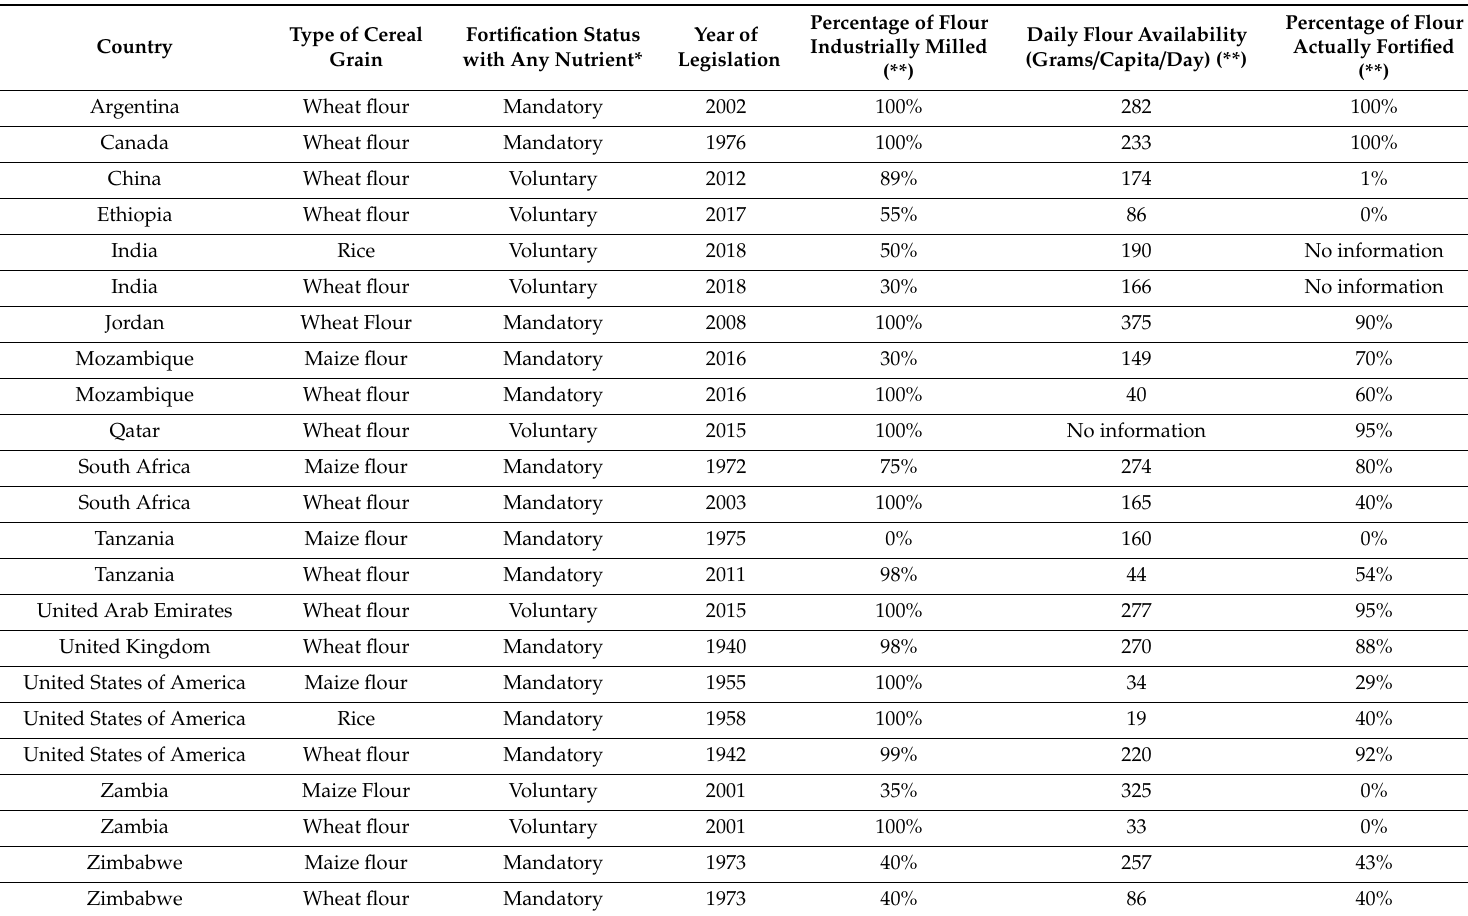
Table 2. Micronutrient fortification standards, and fortification levels of cereal grain in countries of interest, according to the Global Fortification Data Exchange (as of 2018)